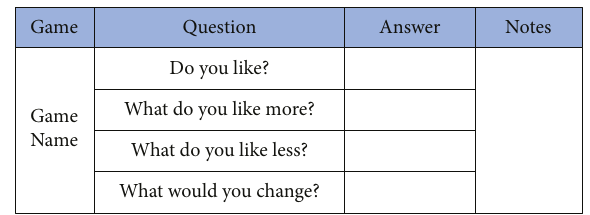
Figure 20: Questionnaire to select minigames in the first intervention (summer school).